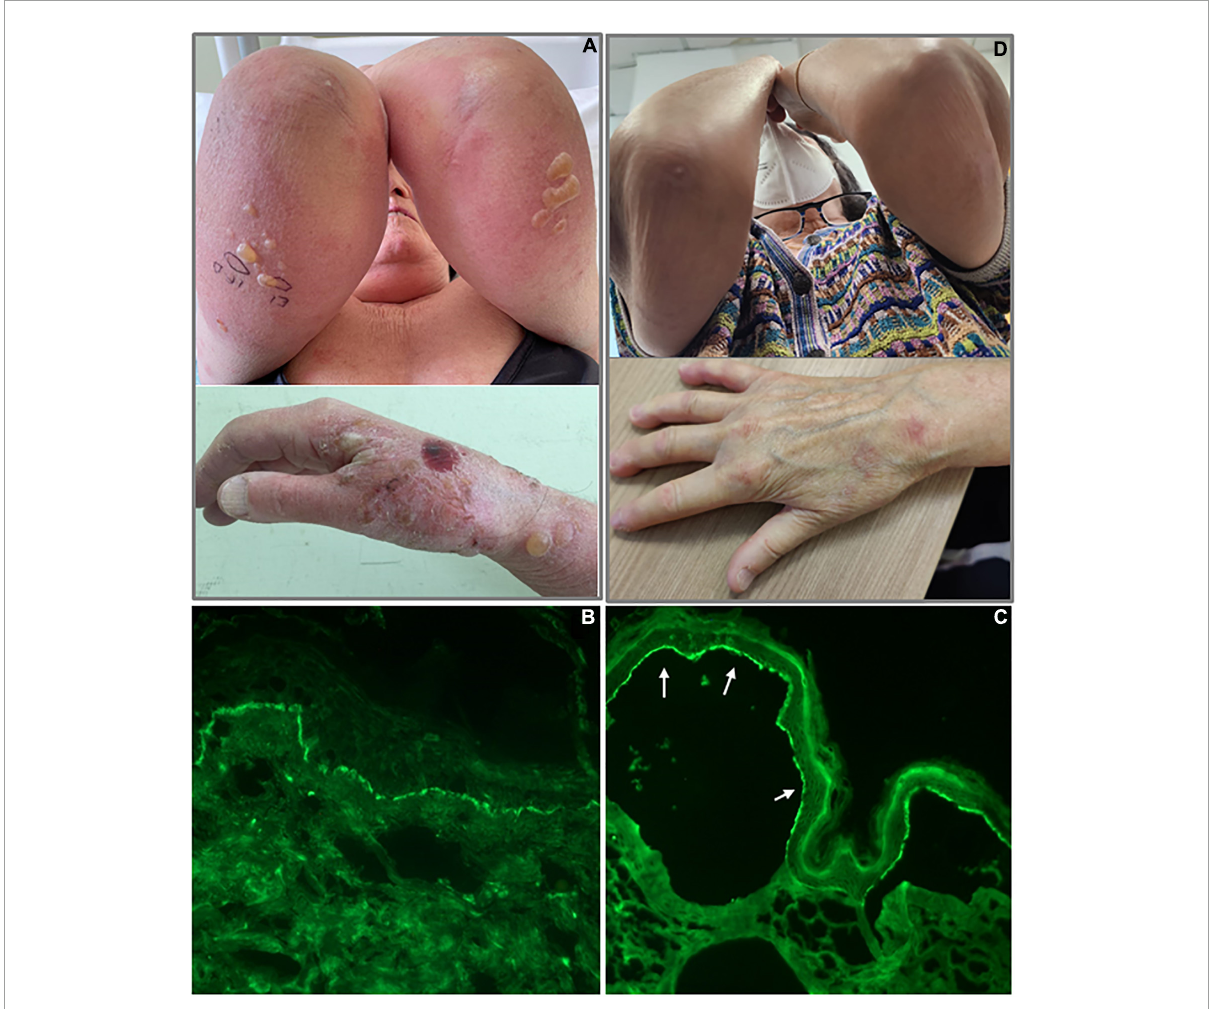
FIGURE1 Clinical and immunological findings of bullous pemphigoid patient. (A) Tense bullae in the upper limbs and the right hand; (B) linear deposition of IgG along the dermo-epidermal junction by direct immunofluorescence; (C) IgG staining of the epidermal side (white arrows) of the artificial blister by indirect immunofluorescence on human salt-split skin; and (D) patient with BP in complete remission on minimal